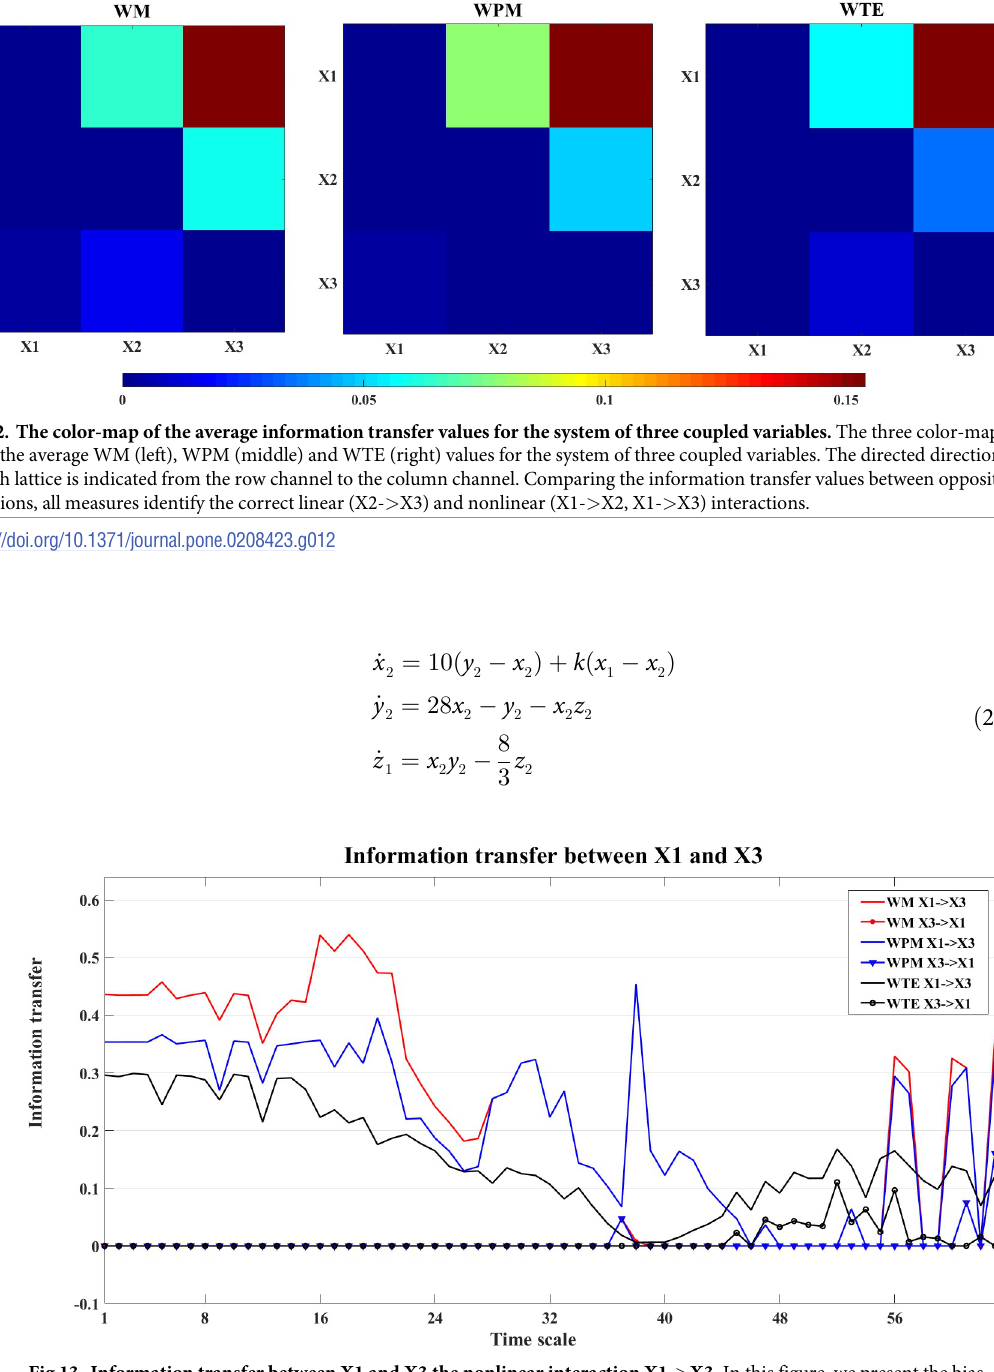
Fig 13. Information transfer between X1 and X3 the nonlinear interaction X1- > X3. In this figure, we present the bias corrected WM (red), WPM (blue) and WTE (black) information transfer between X1 and X3 at different time scales s i (i = 1,2, ... 64). By comparing the strength between opposite directions, all three measures indicate the correct nonlinear interaction from X1- >